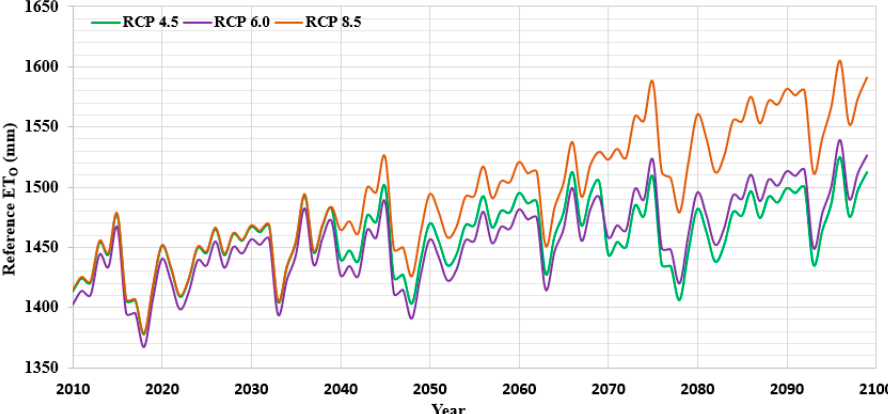
Figure 5. Projected multi-model annual reference evapotranspiration (ET 0 ) for the RCP4.5, RCP6.0, and RCP8.5 scenarios from 2010 to 2099.